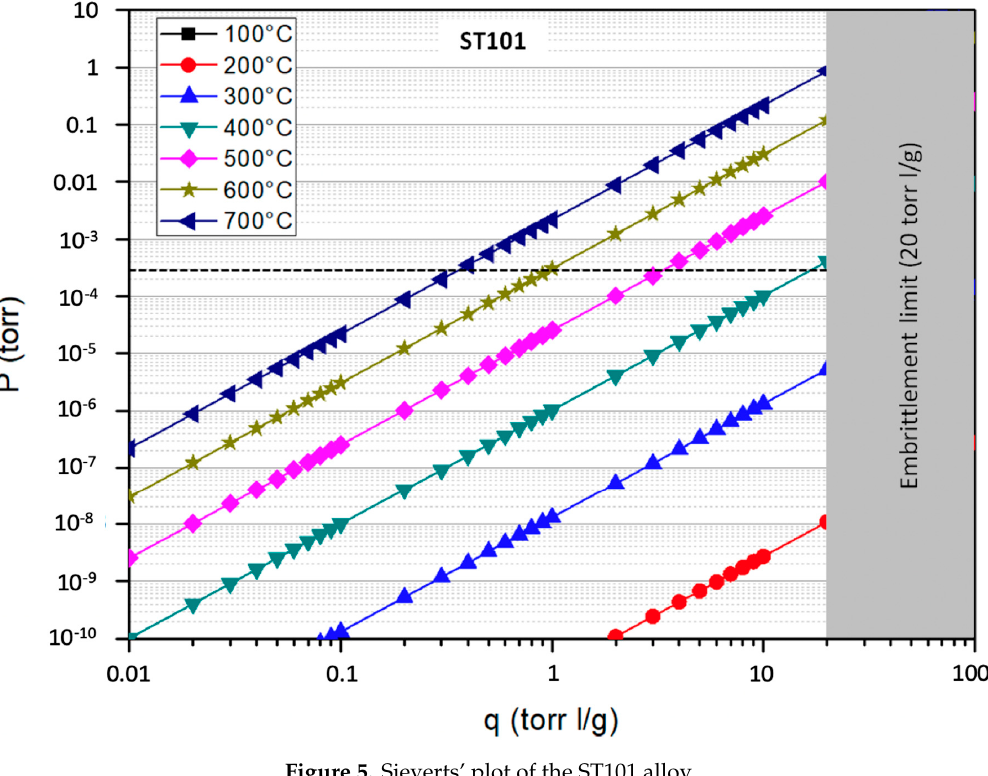
Figure 5. Sieverts’ plot of the ST101 alloy.